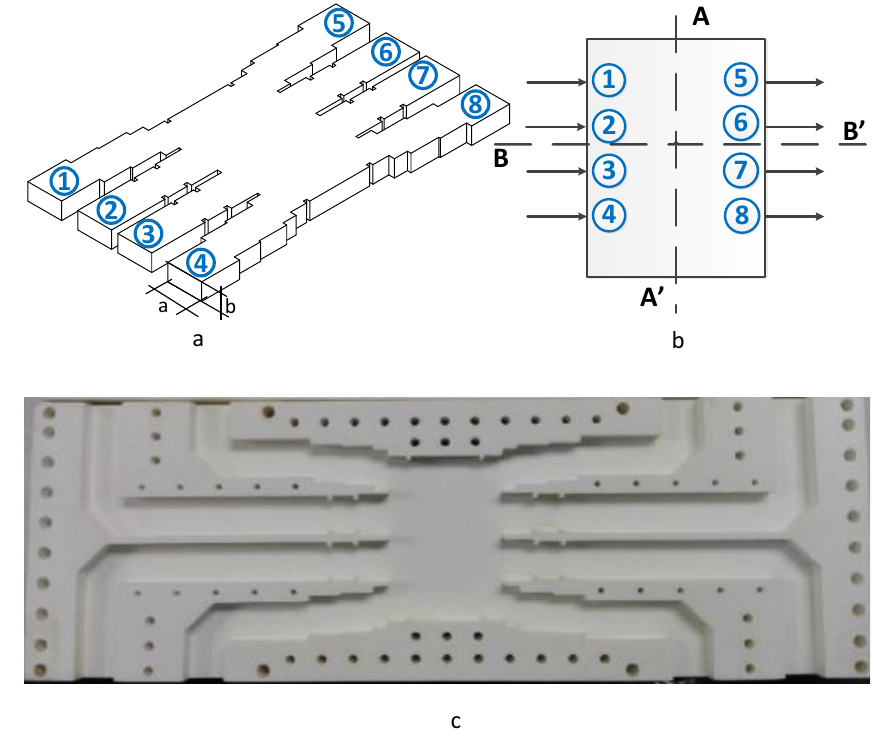
Figure 1. ( a ) Layout of the eight-port coupler. ( b ) Block diagram of the eight-port coupler with two symmetry axes. ( c ) Fabricated part by additive